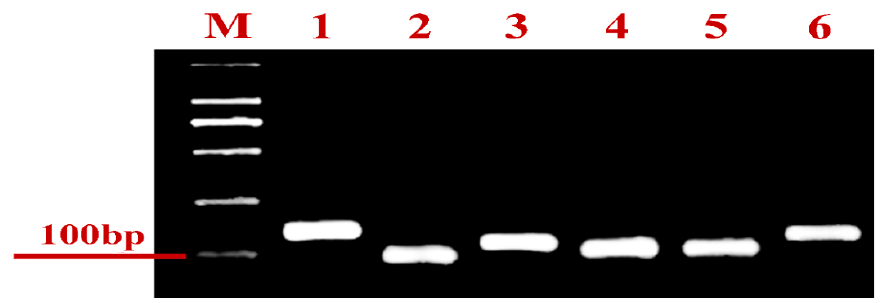
Figure 4. Agarose gel electrophoresis of six genes regulating enzyme of significant correlation with UV exposure. M, Molecular marker. Templates in the polymerase chain reactions (PCRs) were as follows: (1) CAT1 ; (2) CAT2 ; (3) CarE1 ; (4) CarE2 ; (5) PPO1 ; and (6) PPO2